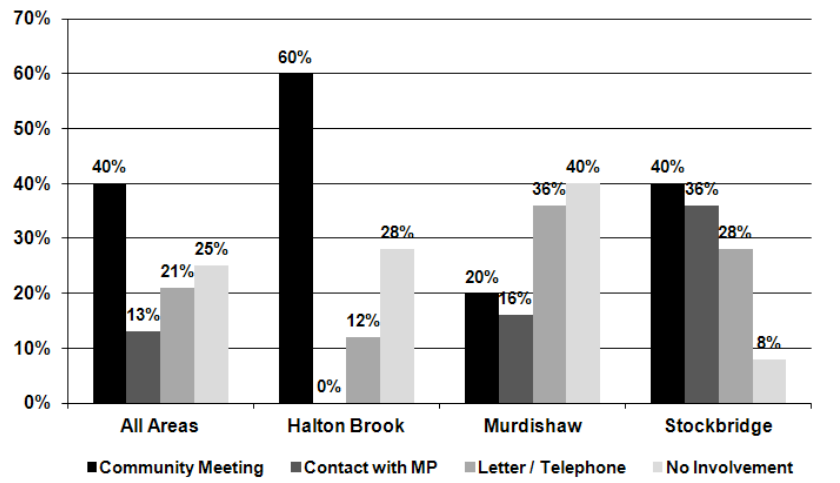
Figure 8. Community involvement and relationship with local authorities. Methods of community